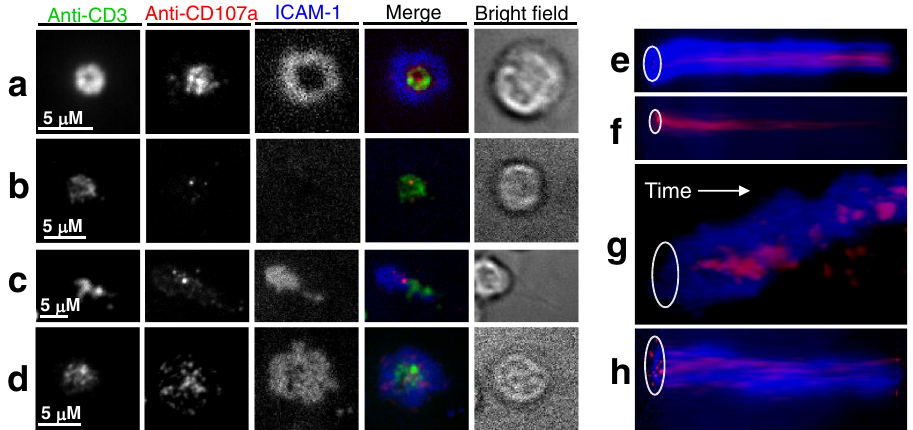
Fig. 6 | Structure of CD8 T cell-bilayer interface is linked to patterns and kinetics of T cells degranulation. CD8 T cells were exposed to the bilayers con- taining anti-CD3 antibodies and ICAM-1 in the presence of anti-CD107a Fab frag- ments. Structure of the interface and cellular degranulation was observed for half anhouraftertheinitialcellcontactswiththebilayersusingTIRF(anti-CD3andanti- CD107a antibodies) and wide fi eld fl uorescence (ICAM-1) microscopy. Repre- sentative images show relative positioning of degranulation foci (red), andi-CD3 antibodies(green)andICAM-1molecules(blue)attheinterfaceofTcellsthatform a mature synapse, b TCR/CD3 focal interface, c kinapse and d multifocal synapse. Images were taken at 30min after T cell loading on bilayers. Scale bars designate